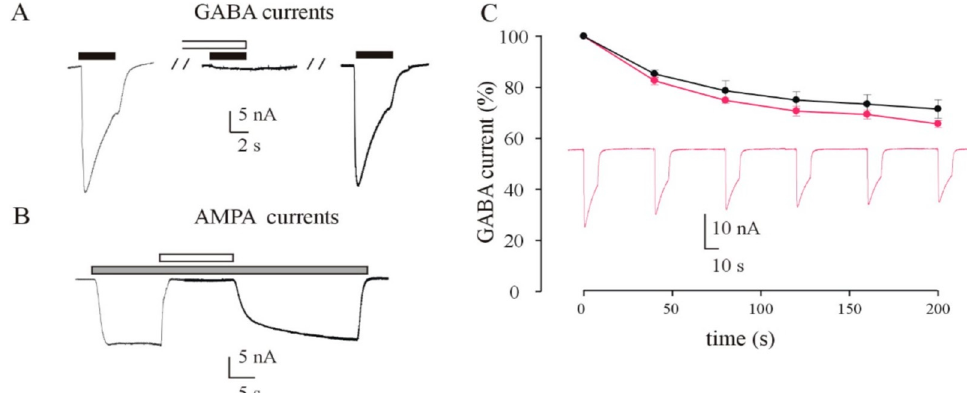
Figure 6. Xenopus oocytes injected with membranes from idNs incorporated functional neurotrans- mitter receptors. ( A ) Sample currents evoked by 500 µ M GABA or ( B ) 20 µ M AMPA on oocytes microinjected with membranes extracted from cultured idNs obtained from a patient carrying the M145T mutation of the SCN1A gene. ( A ) GABA currents were completely inhibited by a brief pre- incubation (30 s) with bicuculline (100 µ M) and subsequently recovered following the washout of the inhibitor. ( B ) AMPA currents were completely inhibited by co-administration of NBQX (50 µ M), and they recovered to the original amplitude once NBQX administration was interrupted. AMPA currents were recorded in presence of CTZ (20 µ M). Black bars = GABA; gray bars = AMPA; white bars in ( A ) bicuculline; in ( B ) NBQX. ( C ) Time course of the GABA current rundown evoked by six consecutive GABA applications (500 µ M, 10 s) interspaced by a 40 s washout, in oocytes injected with membranes from control (black dots; • ) and M145T idNs (magenta; • ; p > 0.05). The dots